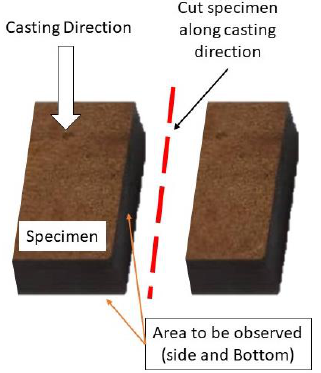
Figure 5. Positions of microstructure.